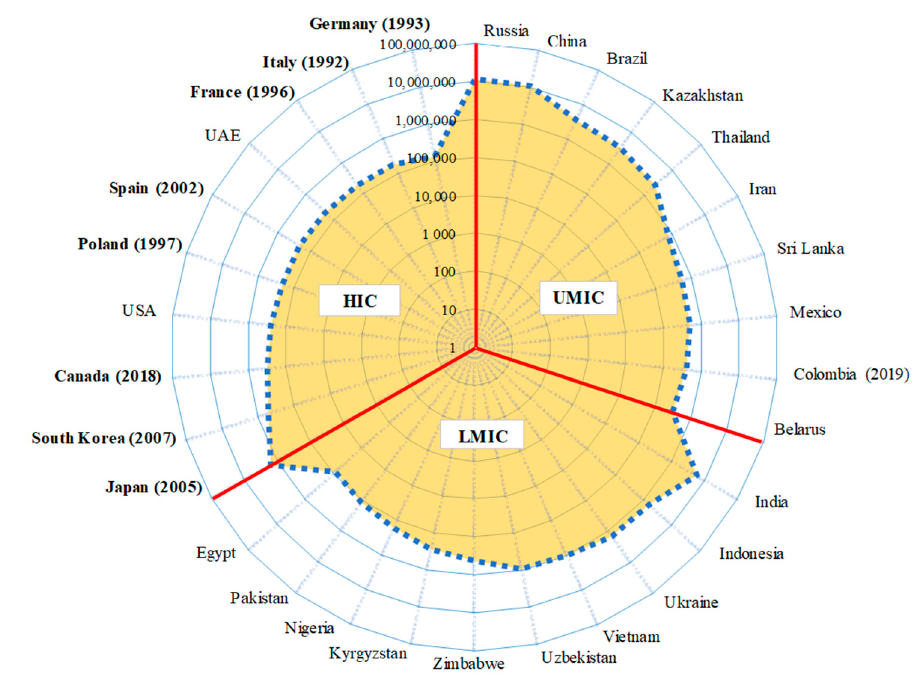
Figure 4. Cumulative Use of Asbestos (metric tonnes) Since 1980 by Country and National Income Category. HIC: High income countries, UMIC: Upper middle-income countries; LMIC: Lower middle income and low-income countries combined. See Table 2 and text for exact definition of national income category. Only top 10 countries in each national income category that recorded the highest cumulative asbestos use since 1980 are shown. Countries that have banned asbestos are shown in bold with the year of banning in brackets.